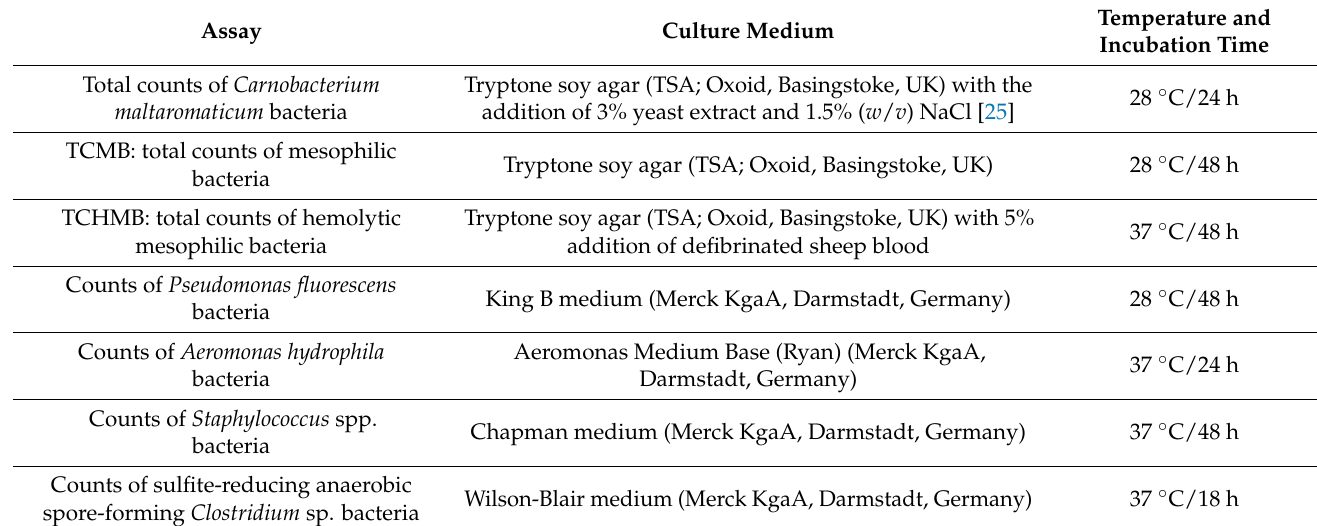
Table 1. Microbiological assays and culturing conditions (temperature and incubation time) during analyses of the digestive tract contents, skin, and feed samples. Culture Medium